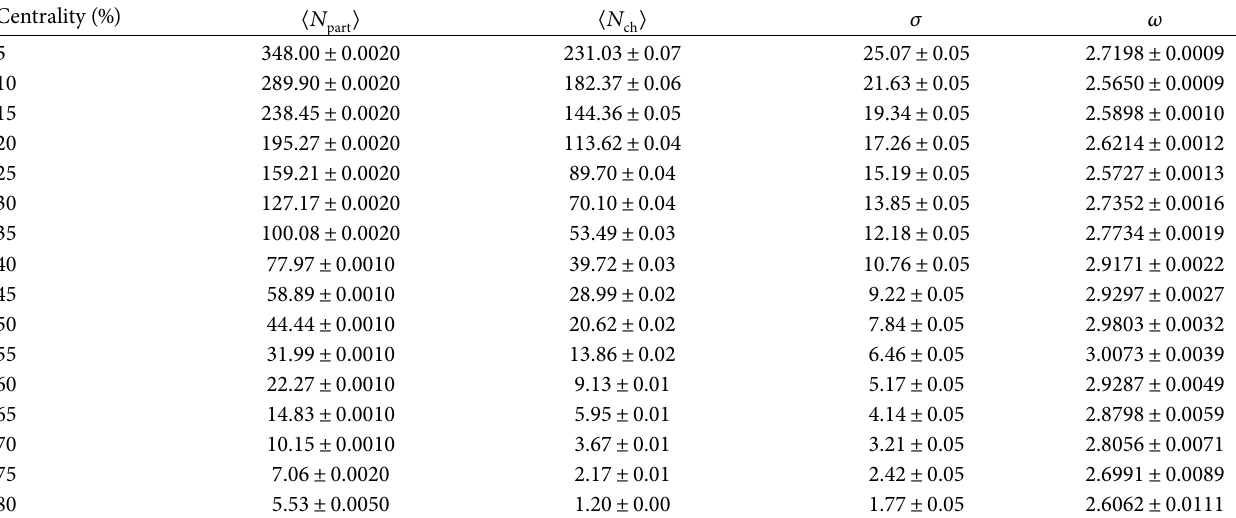
Table 1: Values of ⟨𝑁 part ⟩ , ⟨𝑁 ch ⟩ , dispersion ( 𝜎 ) and scaled variance ( 𝜔 ) in various centrality bins at 𝐸 lab = 10A GeV/c. Centrality ( %